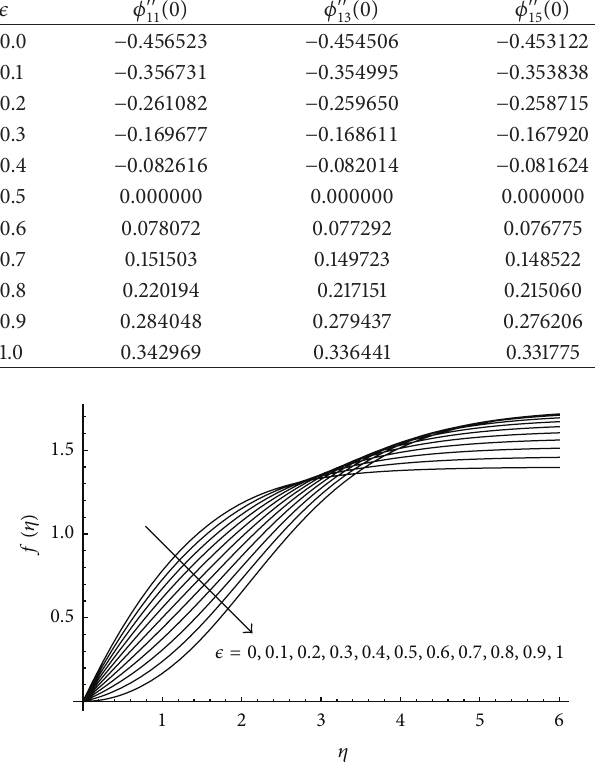
Figure 1: The stream function for the class of the Blasius problem at different values of 𝜖 using 15 terms of the current method.